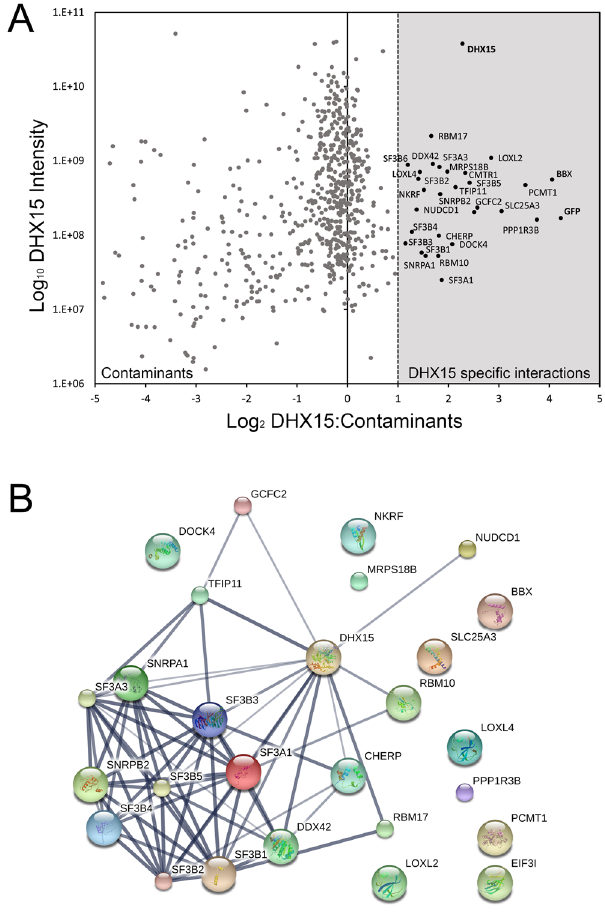
Figure 6. DHX15 interacts with splicing factors from the SF3 complex. ( A ) Control cells were grown in “light” (L) media and cells expressing GFP-DHX15 were grown in “medium” (M) SILAC media. Following lysis, total cell lysates are mixed and subjected to immunoprecipitation using the recombinant GFP-Trap_A reagent. The graph represents the proteins enriched in the immunoprecipitation with a log 2 of the enrichment ration in the x-axis, and a log 10 of the intensity in the y-axis. ( B ) A functional protein association networks using STRING shows several known interactions between members of the splicing factor SF3